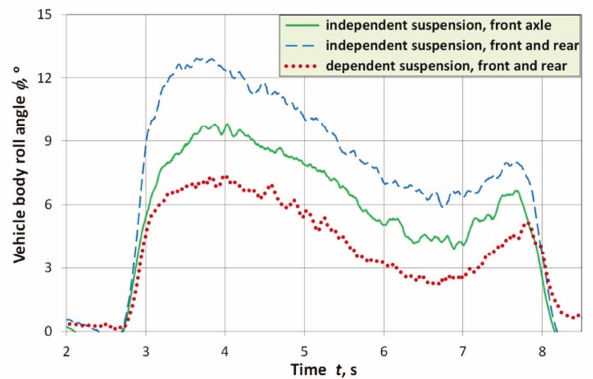
Fig. 12. The run of the vehicle body roll angle during the test. [own re- search]